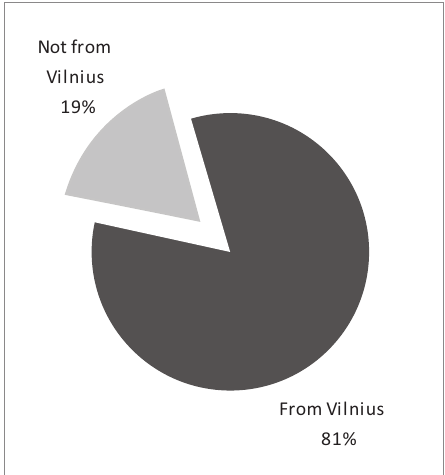
Fig. 1. Destination festival visitors have arrived